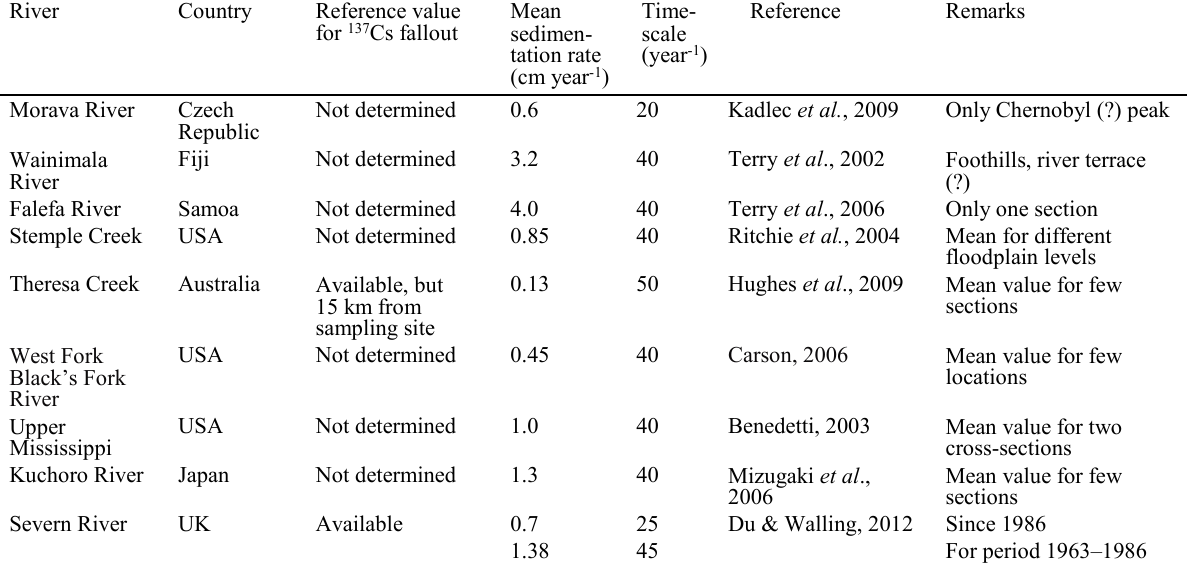
Table 1 Recent rates of overbank floodplain sedimentation estimated using the 137 Cs